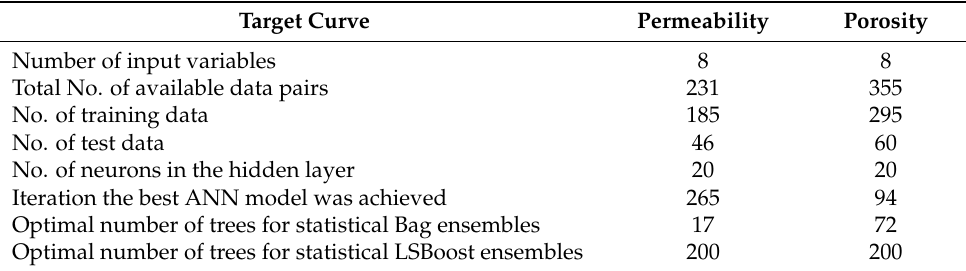
Table 11. Performance of the employed algorithms in estimating petrophysical properties from the post-stack seismic data.